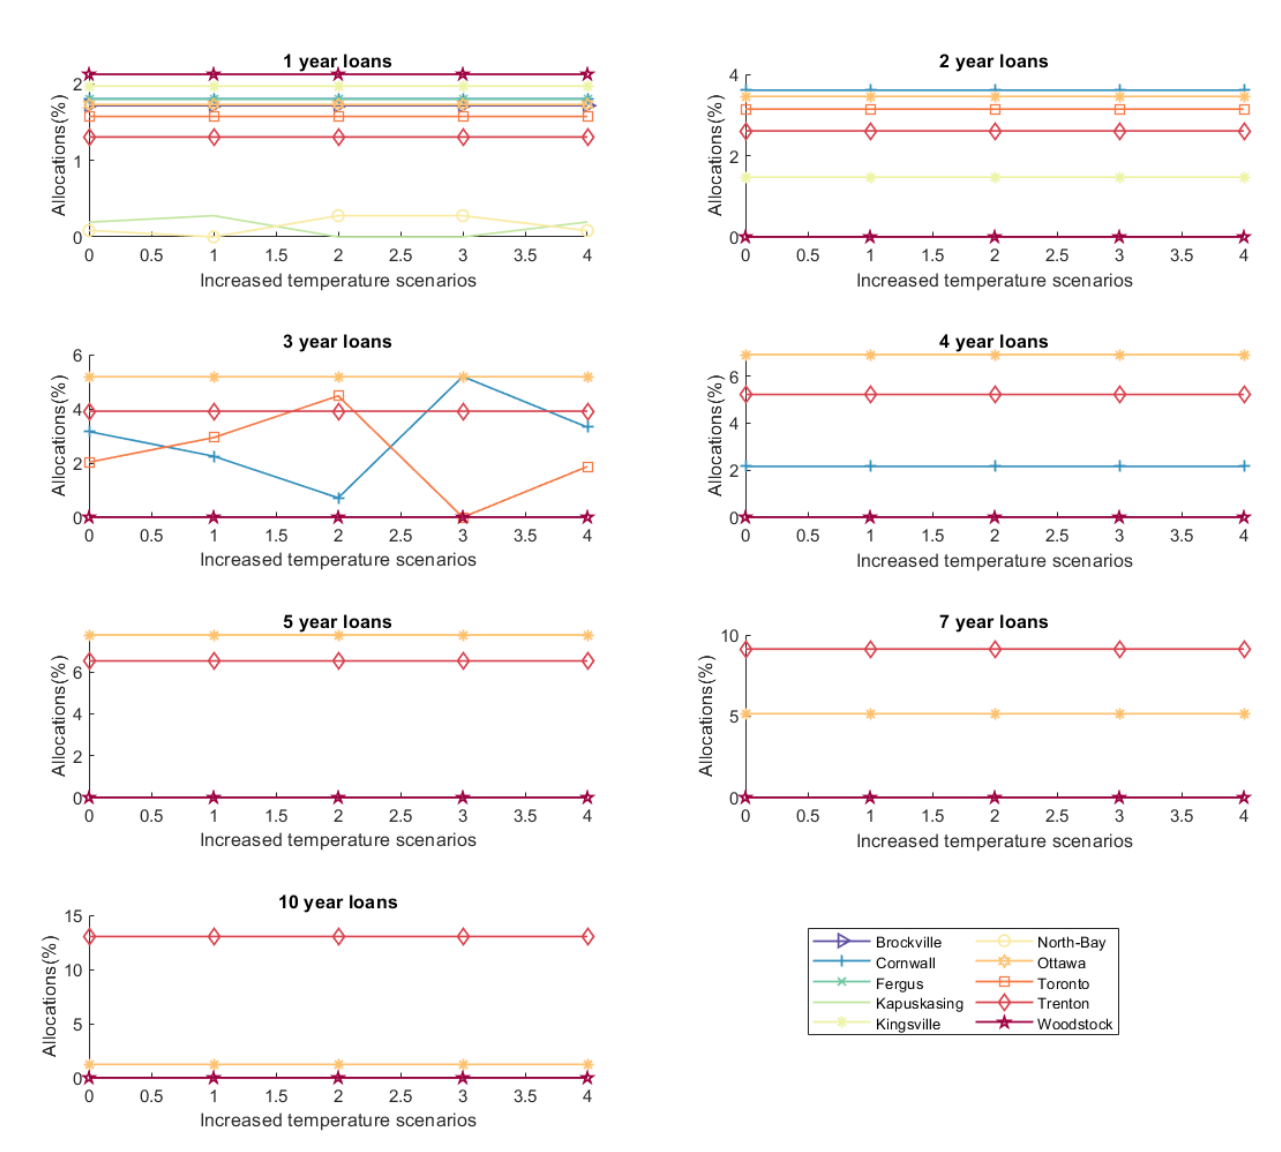
Figure 7. Allocations to each region when the entire budget is equally distributed among loans of all tenors under five different 1 ◦ C increased temperature